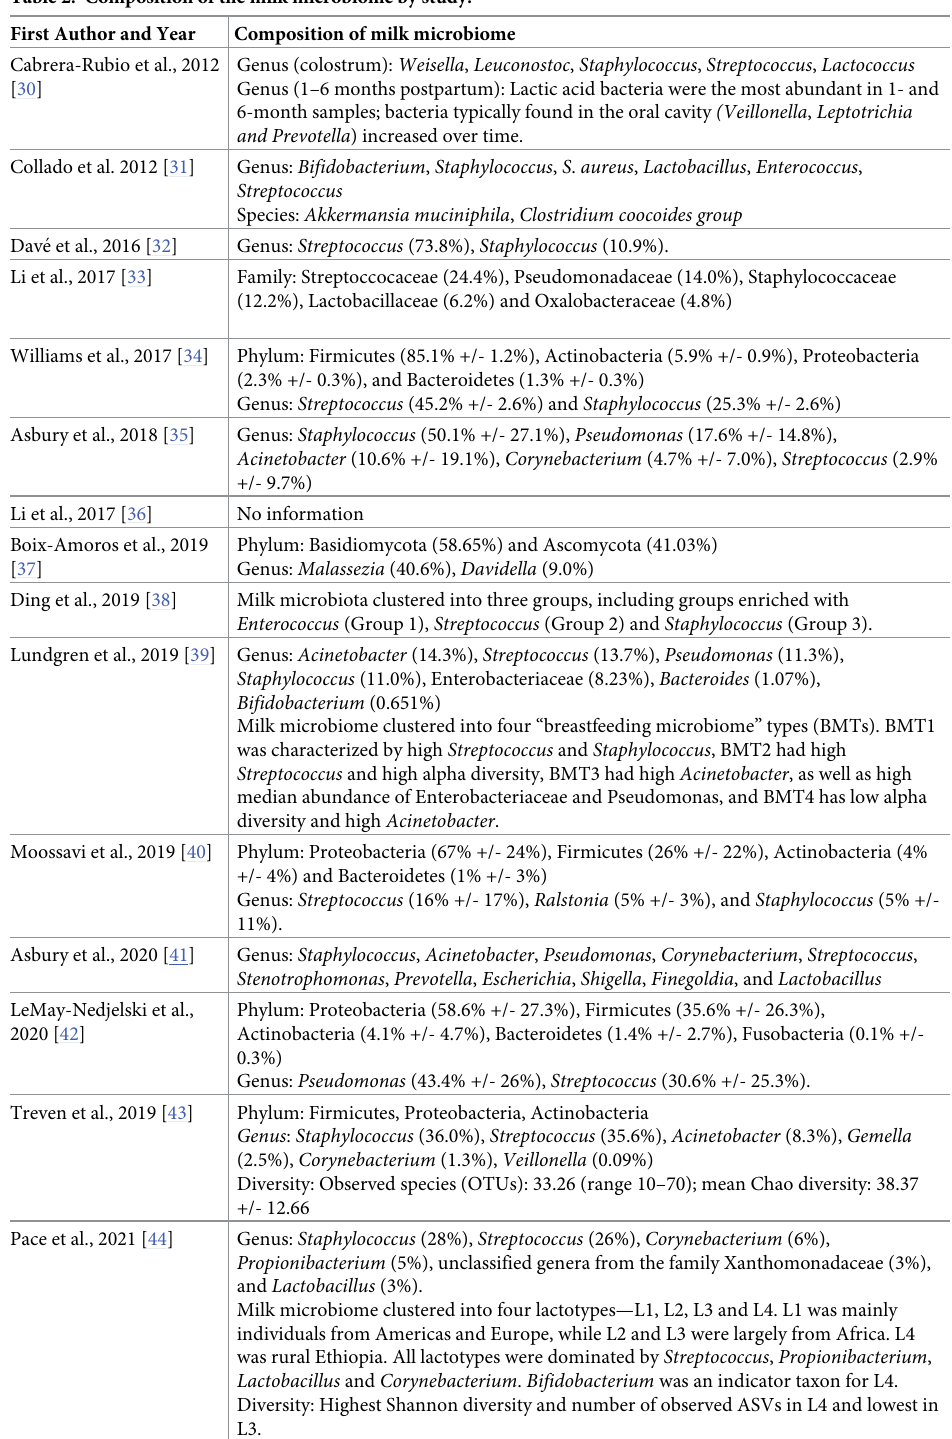
Table 2. Composition of the milk microbiome by